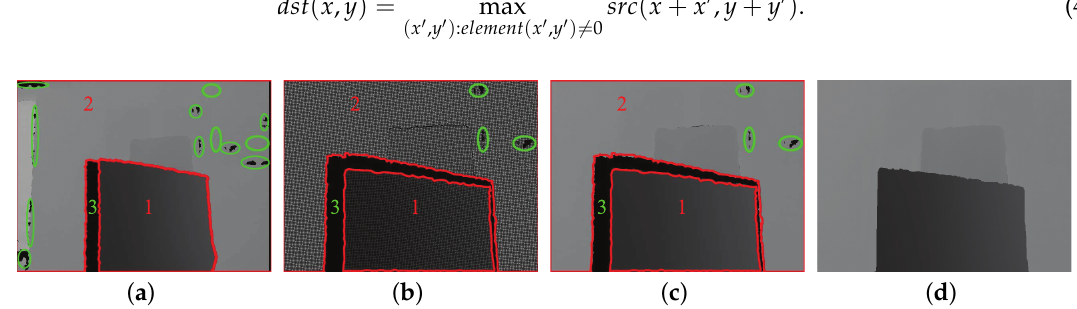
Figure 4. Depth map preprocessing: ( a ) raw depth map from the Kinect depth sensor, ( b ) aligned depth map, ( c ) aligned depth map after dilation, and ( d ) aligned depth map after hole filling. Black holes are labelled with green-coloured ellipses; the largest hole is labelled with “3” in green colour; the front object region and background region are labelled with “1” and “2”,